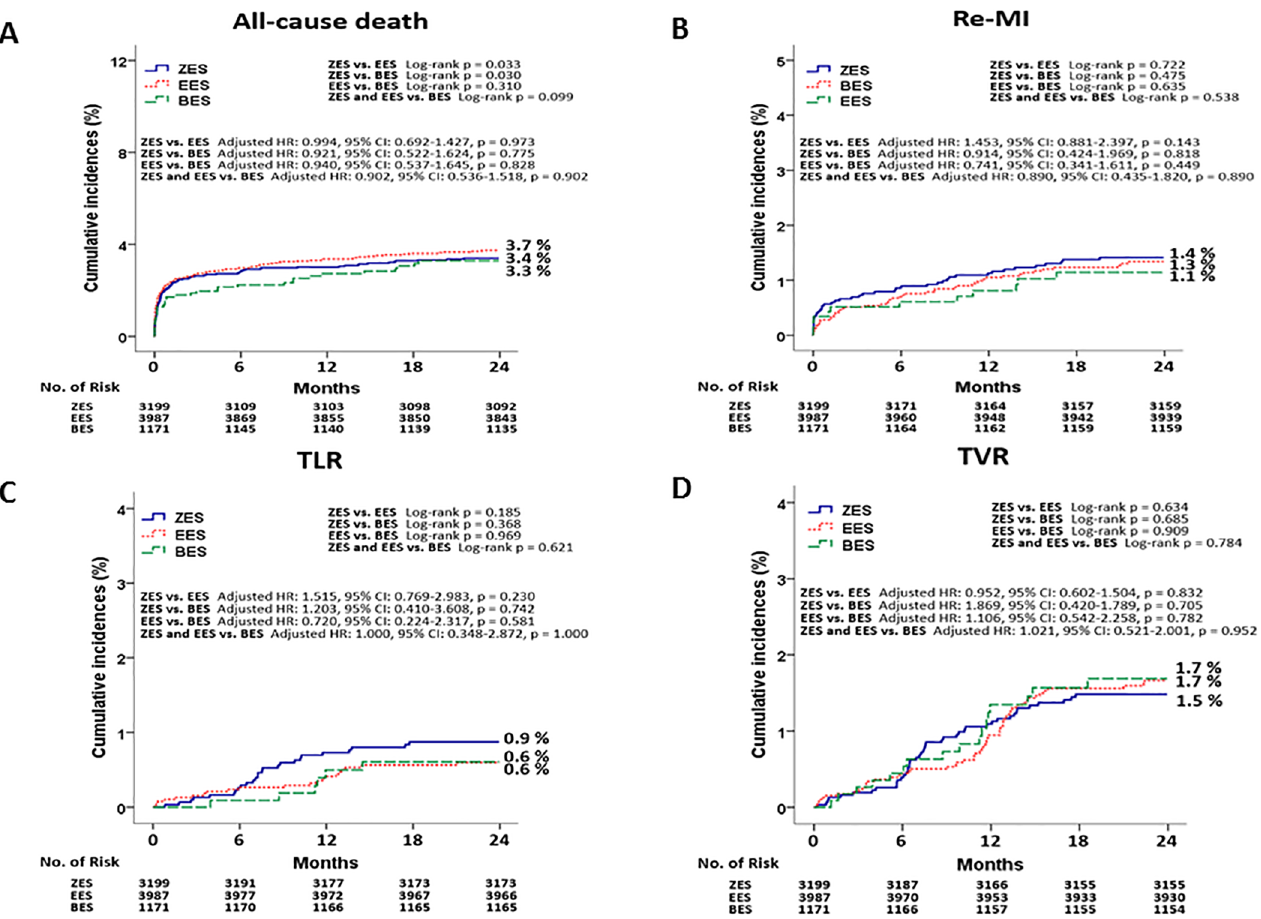
Fig 3. Kaplan-Meier Curved Analysis for all–cause death (A), Re-MI (B), TLR (C), and TVR (D). MI, myocardial infarction; ZES, zotarolimus-eluting stent; EES, everolimus-eluting stent; BES, biolimus-eluting stent; HR, hazard ratio; CI, confidence interval; TLR, target lesion revascularization; TVR, target vessel